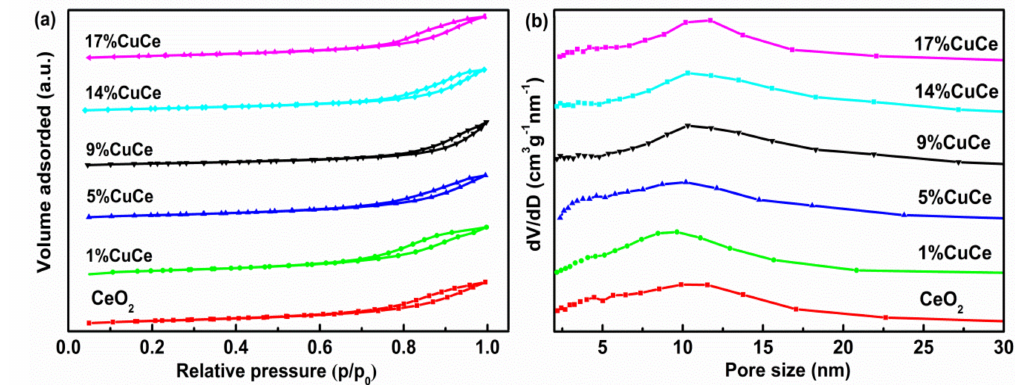
Figure A1. ( a ) N 2 adsorption-desorption isotherms curves; ( b ) pore size distribution calculated